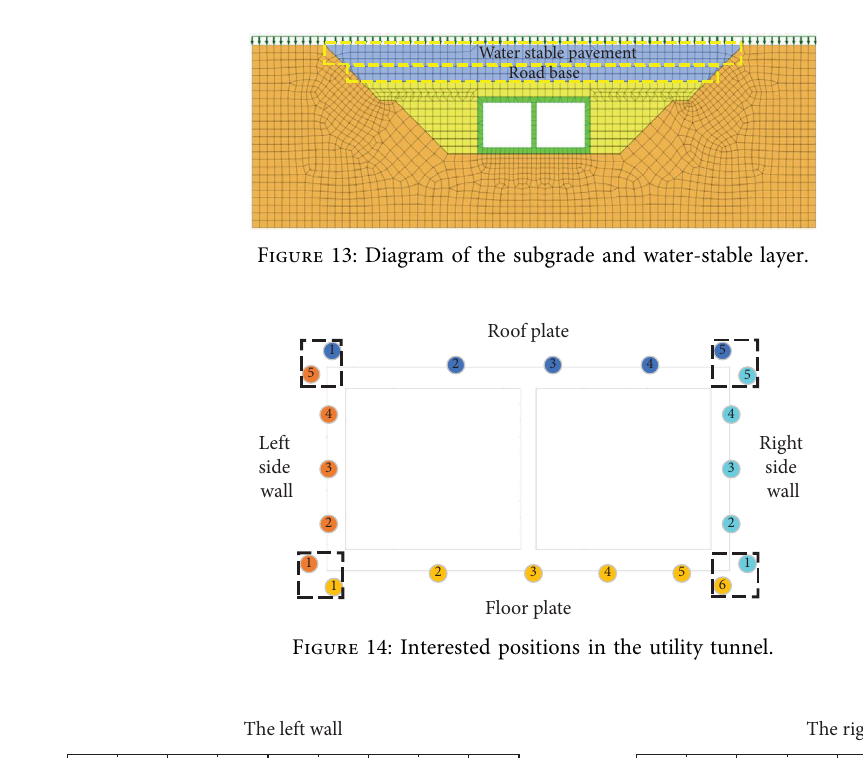
Figure 12: Backflling from middle to both sides: Case II.